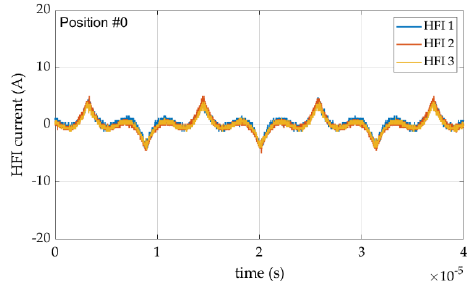
Figure 16. HFIs output currents in not ‐ coupled condition (Position #0).